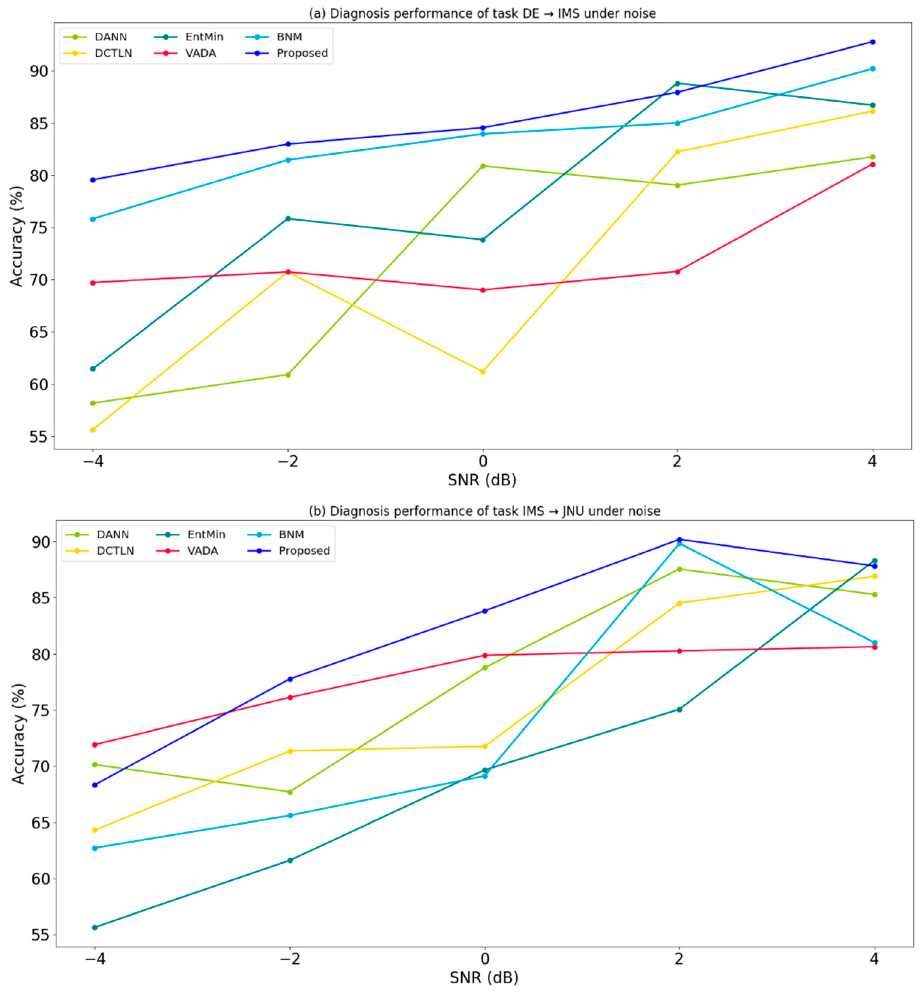
Figure 5. Results of fault diagnosis accuracies under different noise levels in the task ( a ) DE → IMS, ( b ) IMS → JNU. The number of target samples each class is 5.